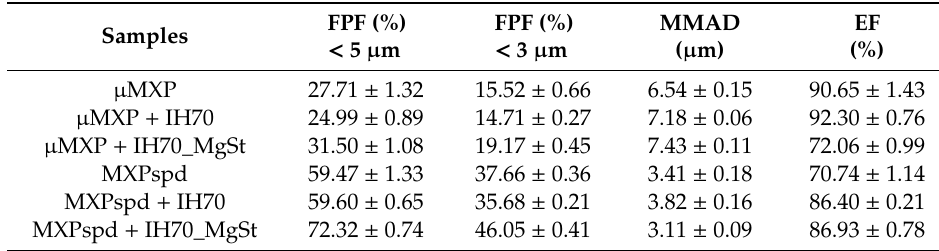
Table 5. Aerodynamic properties of the